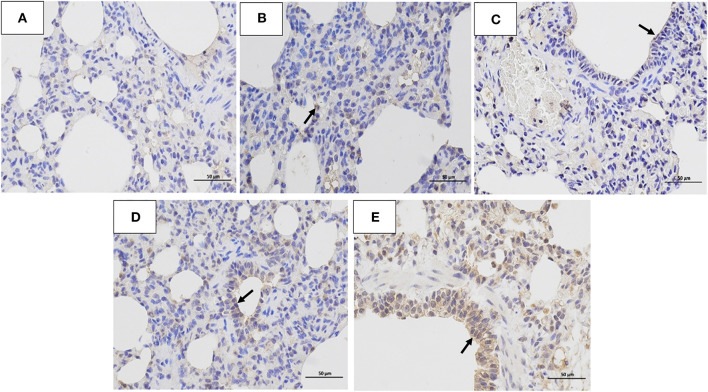
Immunohistochemistry analysis. Immunohistochemistry (IHC) analysis of the lungs of dogs challenged with different doses of H3N2 CIV: (A) control group; (B) 103 EID50 challenge group; (C) 104 EID50 challenge group; (D) 105 EID50 challenge group; and (E) 106 EID50 challenge group. The arrows refer to GD14 antigen expression.